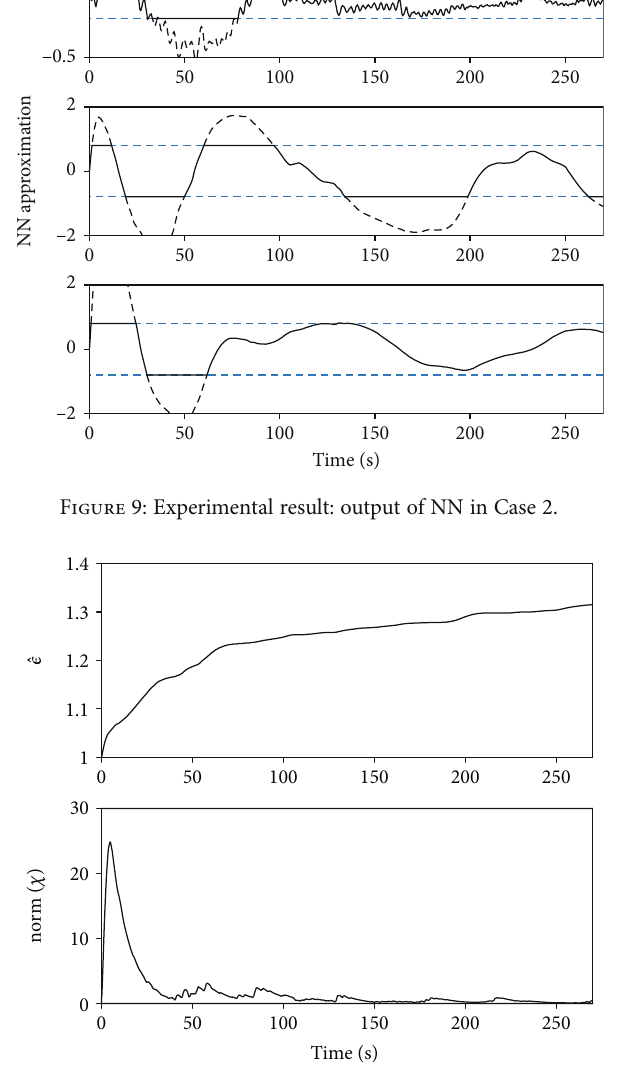
Figure 10: Experimental result: estimate value and auxiliary signal in Case 2. Table 5: Standard derivations of tracking